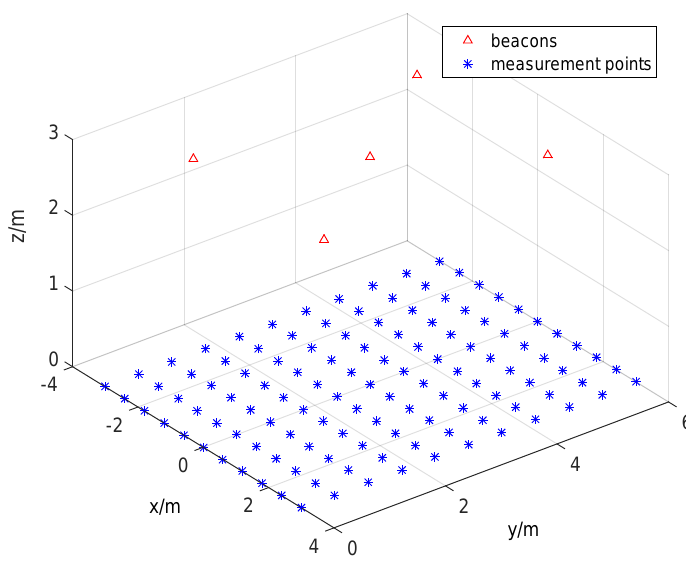
Figure 12. The configuration of the simulation.